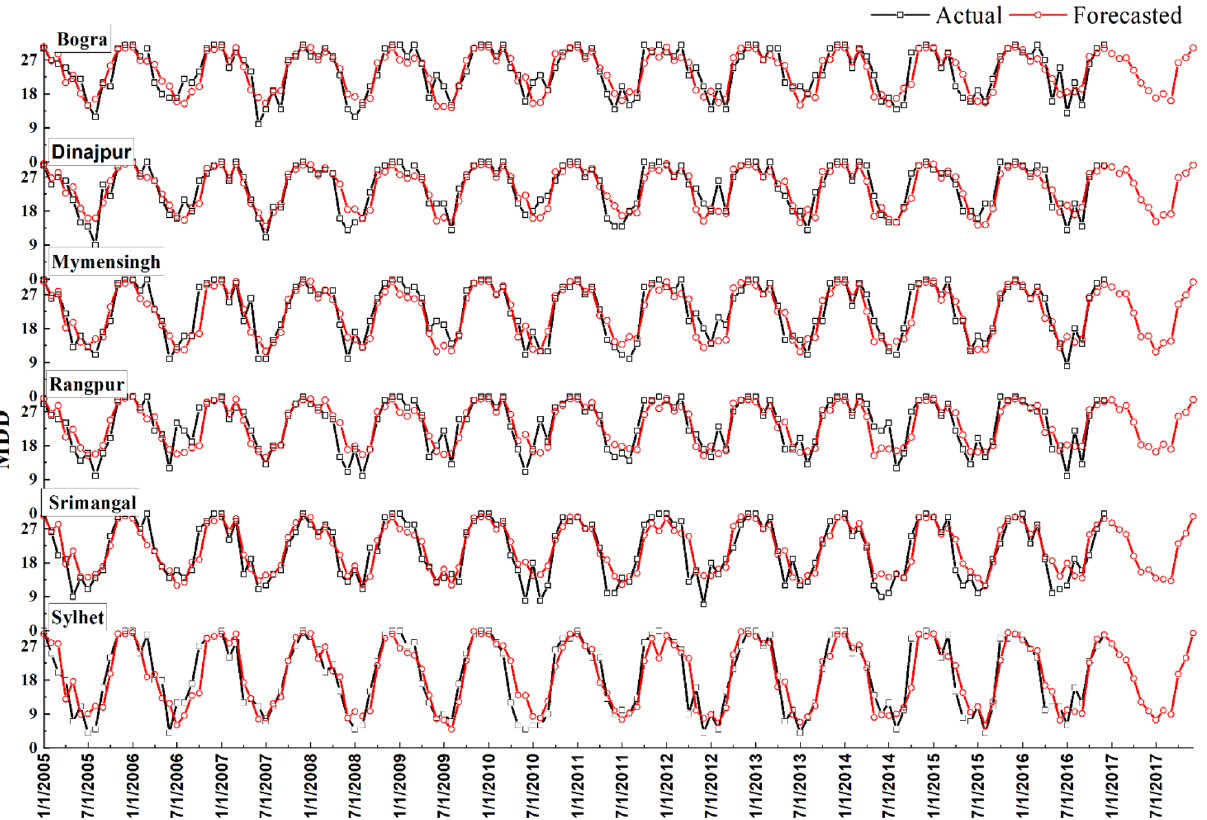
Figure 4. Forecasted MDD using EGPR for Sylhet, Srimangal, Rangpur, Mymensingh, Dinajpur and Bogra